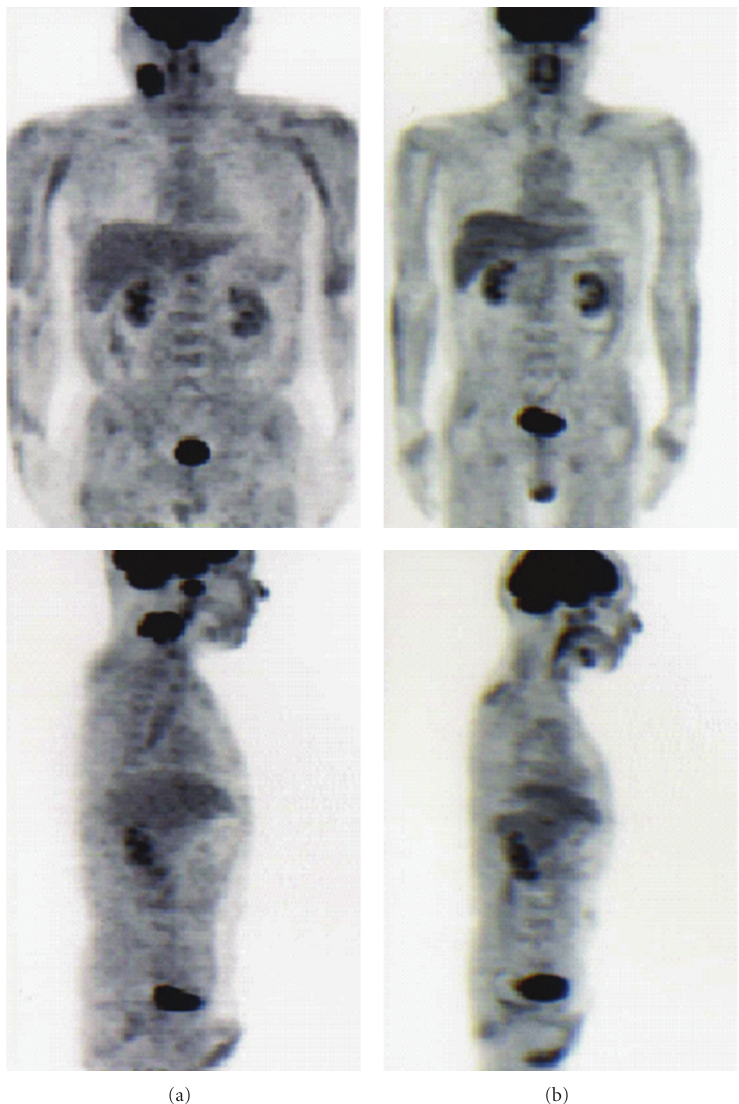
Figure 4: PET-CT. (a) Pre-treatment. Intense FDG uptake is detected in the left cervical region and the nasopharynx. Mild FDG uptake is detected in the muscles of the entire body, especially the upper extremities. (b) Post-treatment. FDG uptake with residual tumor is not detected. FDG uptake in the muscles is improved compared to